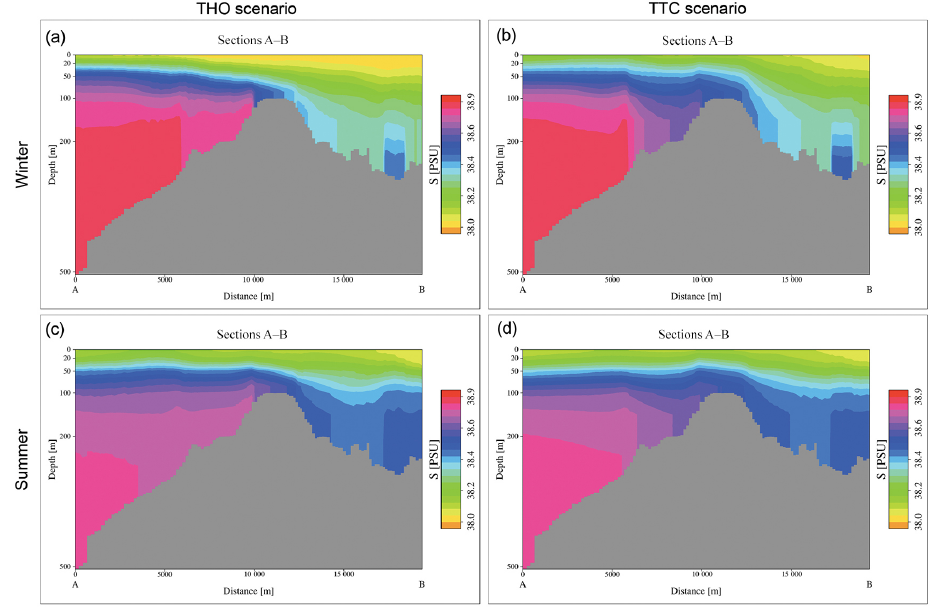
Figure 7. Vertical distribution of the average water salinity expressed in PSU computed along the sections A–B from THO ( a and c ) and TTC scenario results ( b and d ) for winter ( a and b ) and summer periods (panels c and).